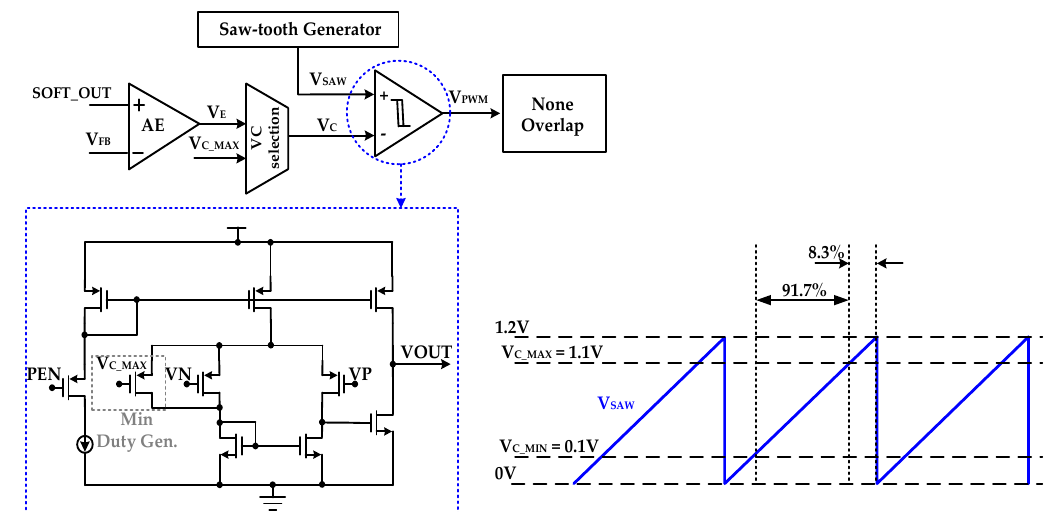
Figure 7. The pulse width modulation (PWM) signal min-max duty generator.